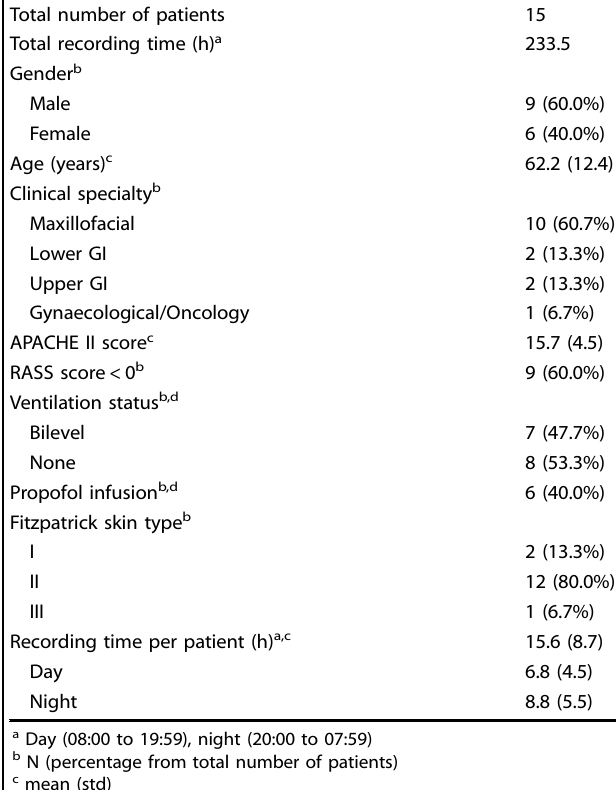
Table 1. Summary of the study